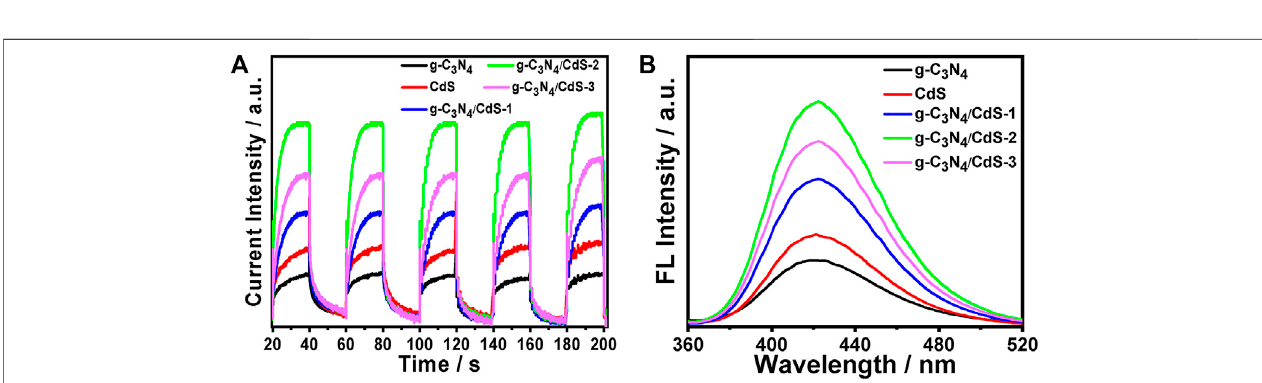
FIGURE8|(A) Photocurrentsofg-C 3 N 4 ,CdS,andg-C 3 N 4 /CdShybridsundervisiblelightirradiationunder0.8 V versus Ag/AgClelectrodebias. (B) Fluorescence spectra of g-C 3 N 4 , CdS, and g-C 3 N 4 /CdS hybrids in a basic solution of terephthalic acid under visible light irradiation at a fi xed time.